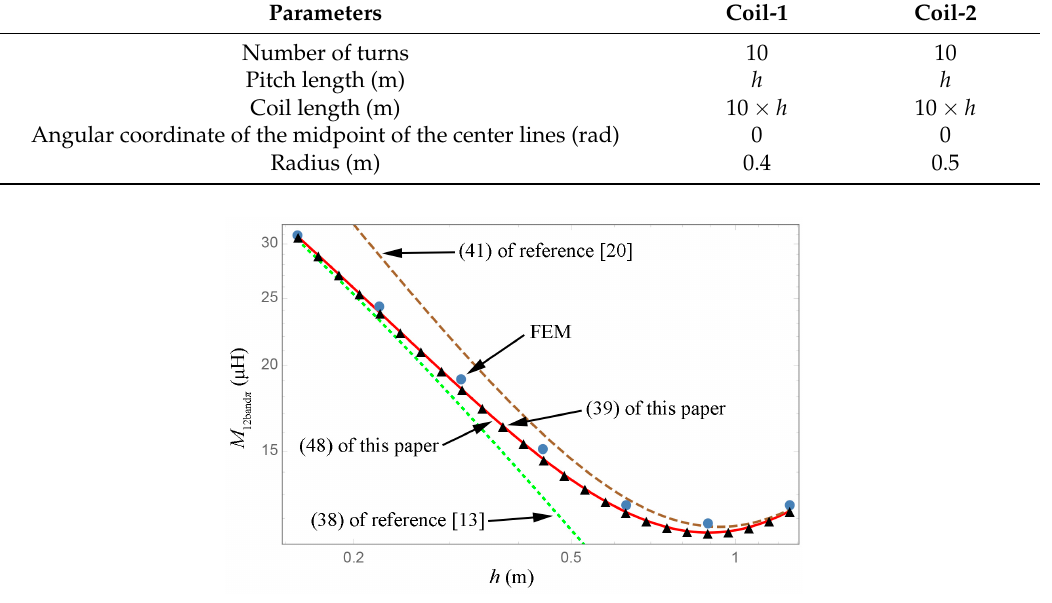
Figure 16. Pitch length ( h ) dependence of the mutual inductance ( M 12band π ) of closely wound tape coils.